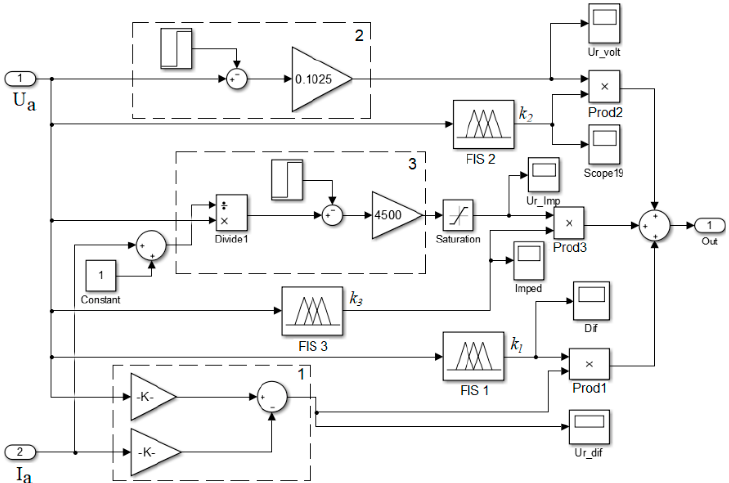
Figure 2. Structural block-scheme of the Simulink model of additive three-component fuzzy law (6) of the formation of a mismatch signal.